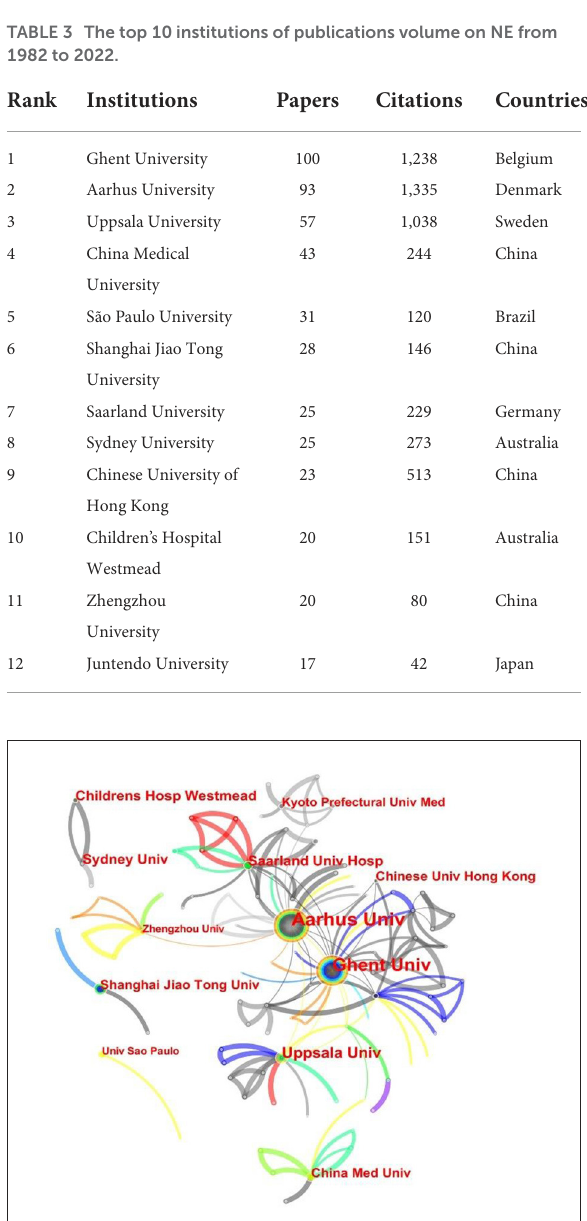
FIGURE4 Network of institutions’ cooperation on NE research. Each circle represents an institution. The size of the circle is positively related to the number of articles published by the organization, and the thickness of the line is positively correlated with the frequency of